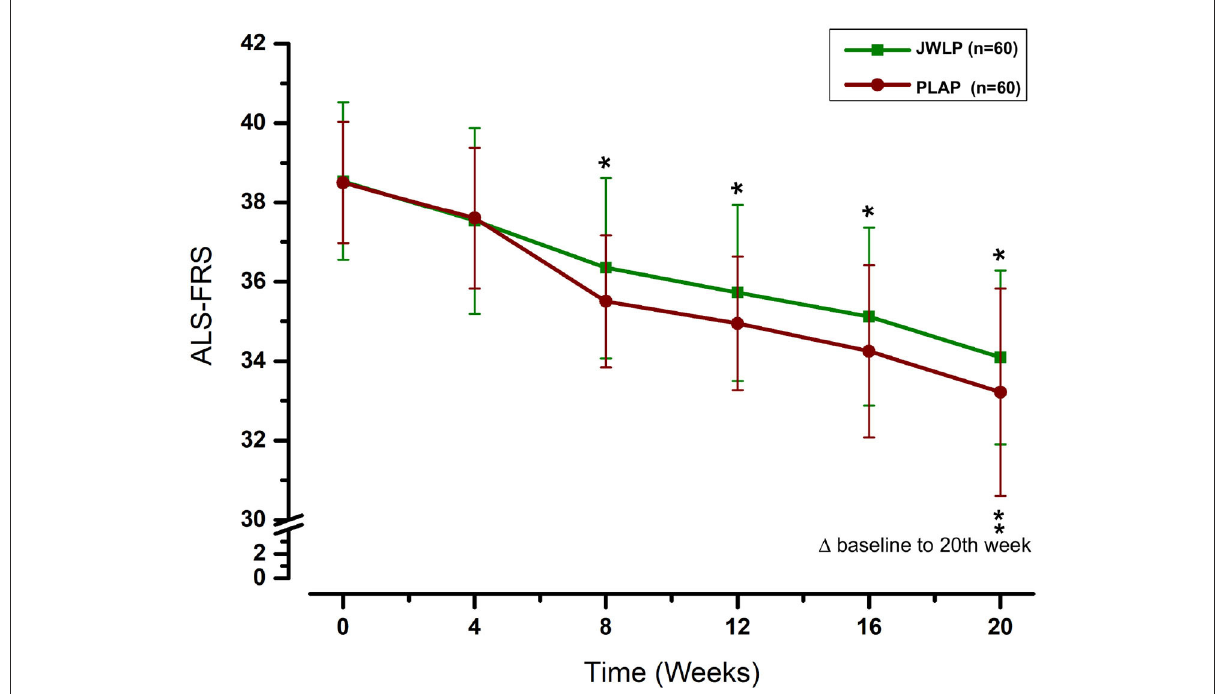
FIGURE4 Change over time in the ALSFRS-R over the 20 week trial period. * p < 0.05, ** p < 0.01.